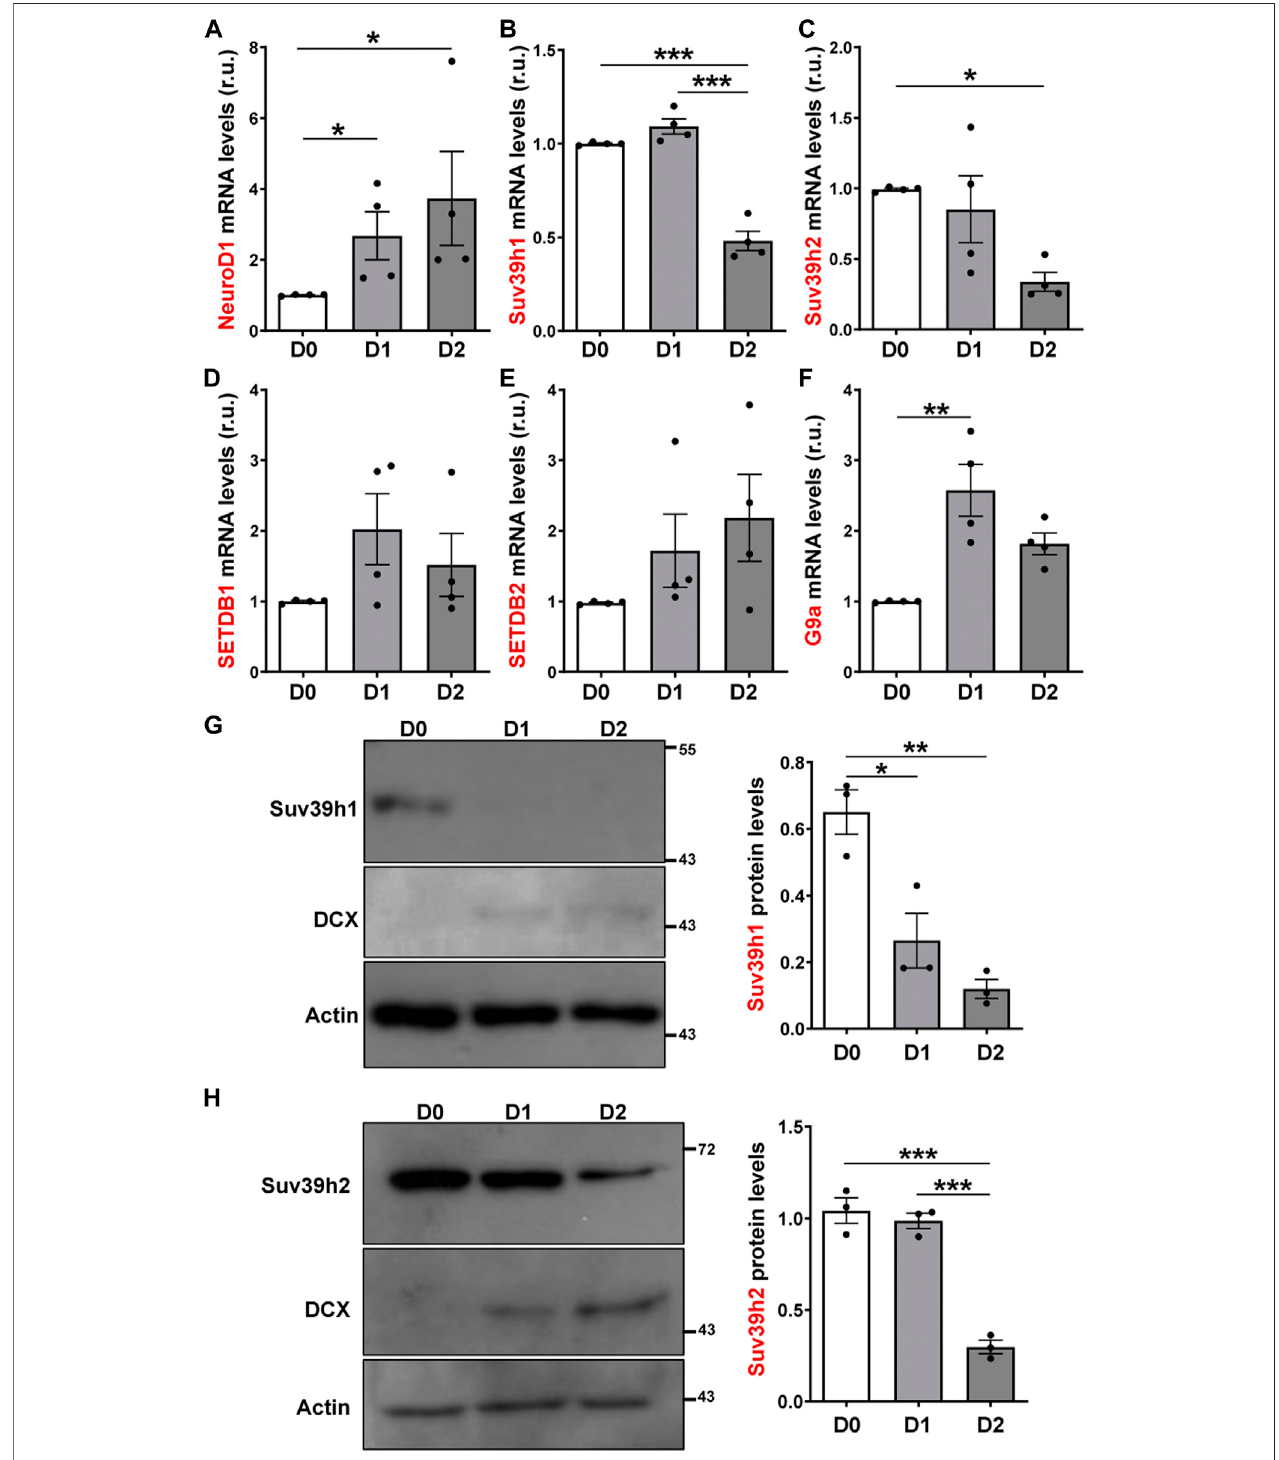
FIGURE5| Expression ofH3K9methyltransferases incultured adulthippocampal progenitors. (A – F) RT-qPCR fromtotal RNAisolated fromAHP undifferentiated (D0)ordifferentiatedbygrowthfactorwithdrawalfor24(D1)and48(D2)h.mRNAlevelsofNeuroD1 (A) ,Suv39h1 (B) ,Suv39h2 (C) ,SETDB1 (D) ySETDB2 (E) andG9a (F) , were normalized to GAPDH mRNA and expressed relative to D0. (G, H) Immunoblot analysis of Suv39h1 (G) and Suv39h2 (H) in total protein extracts from AHP at D0, D1 and D2. DCX was used as a positive control of differentiation. Numbers on the right indicate molecular weight (kDa). Suv39h1/h2 protein levels were normalizedtoactin.Dataarepresentedasmean ± SEM. N (cid:1) 4(RT-qPCR) or N (cid:1) 3(immunoblot)independent experiments. * p < 0.05,** p < 0.01,*** p < 0.001, one-way ANOVA followed by Bonferroni posthoc test.